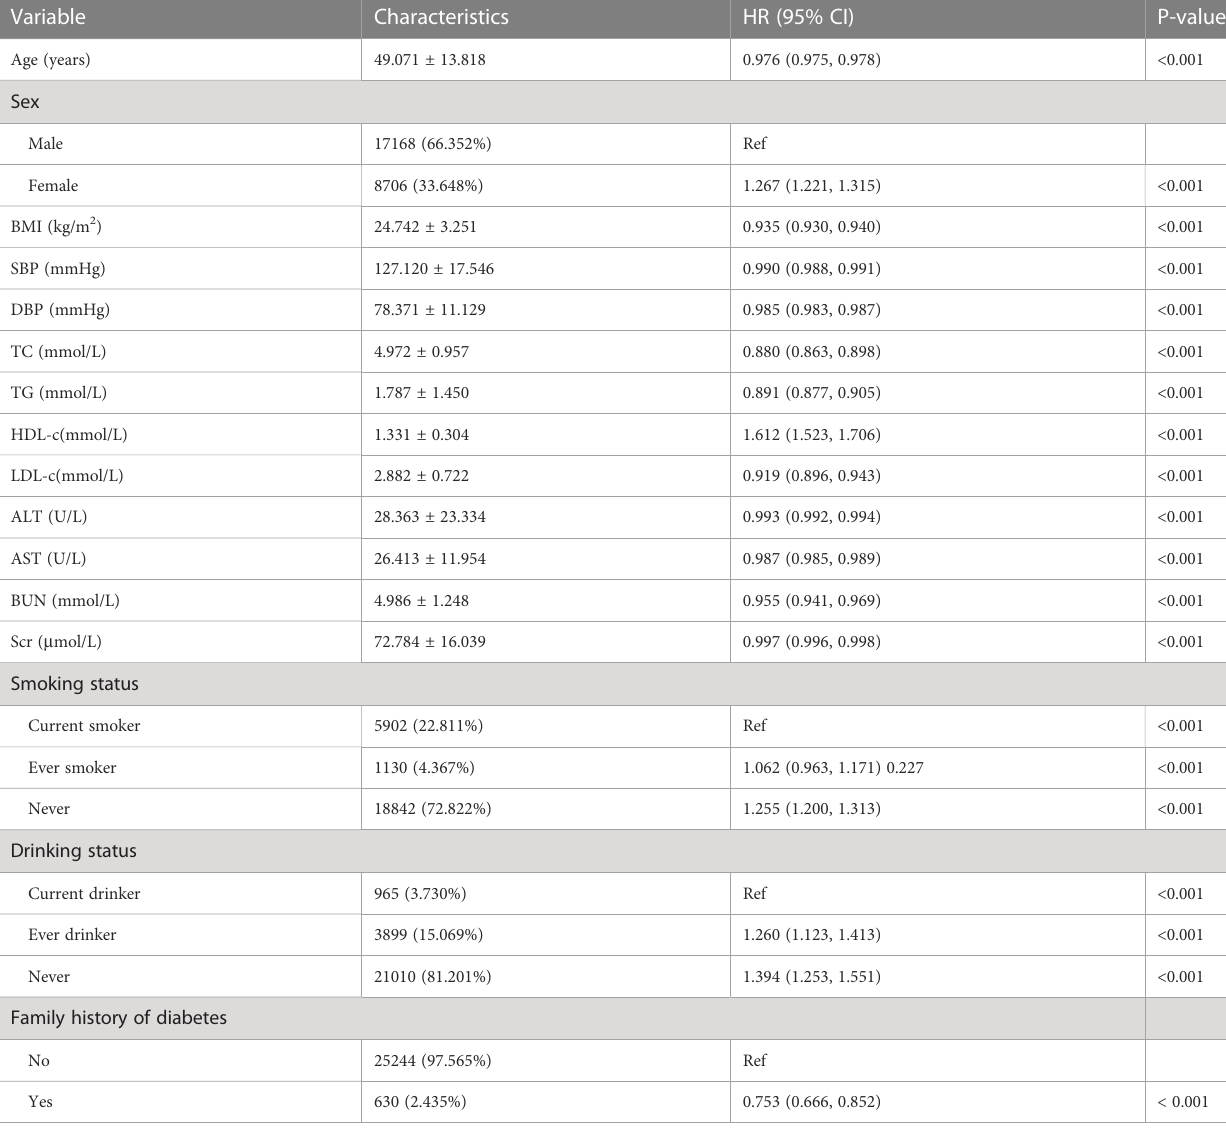
TABLE 3 Factors in fl uencing reversion to normoglycemia among participants with IFG analyzed by univariate Cox proportional hazards regression. Variable